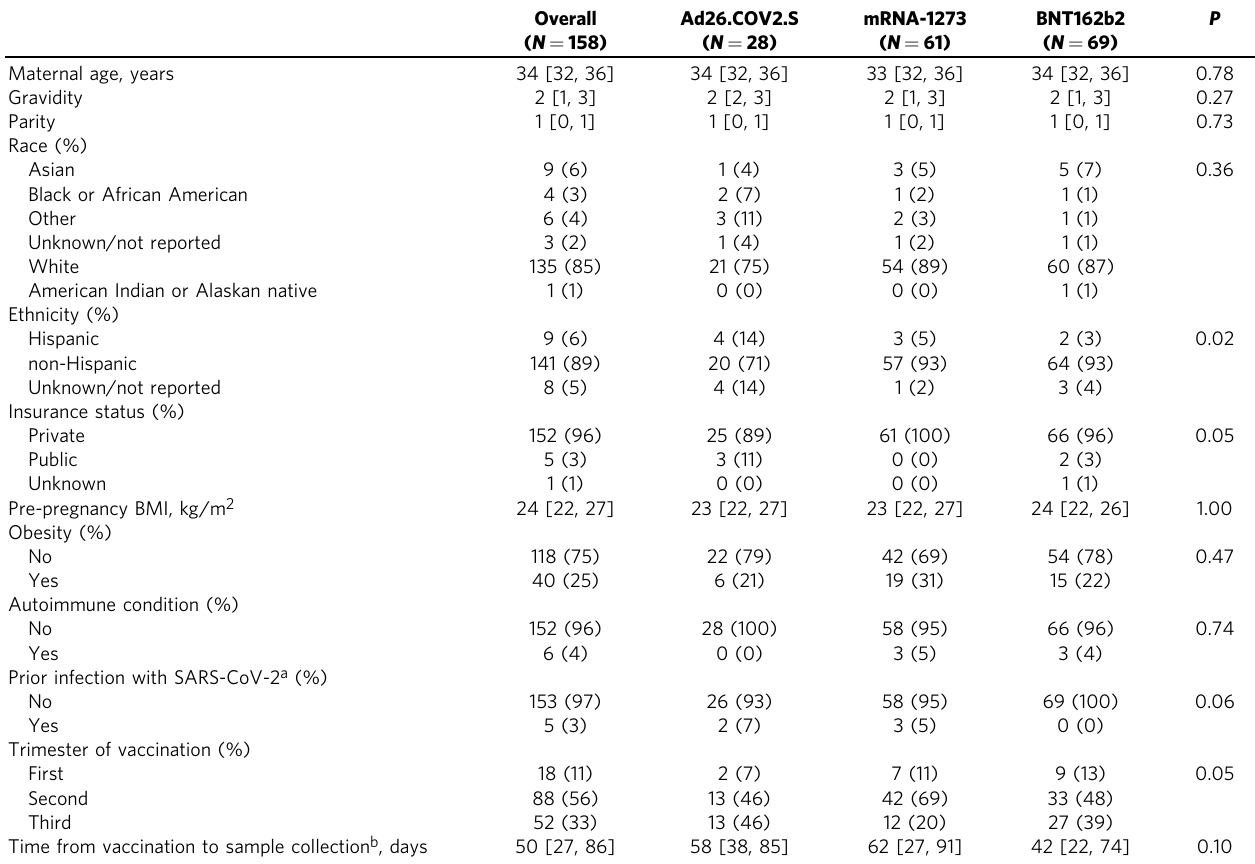
Table 1 Demographic and clinical characteristics of maternal participants by vaccine